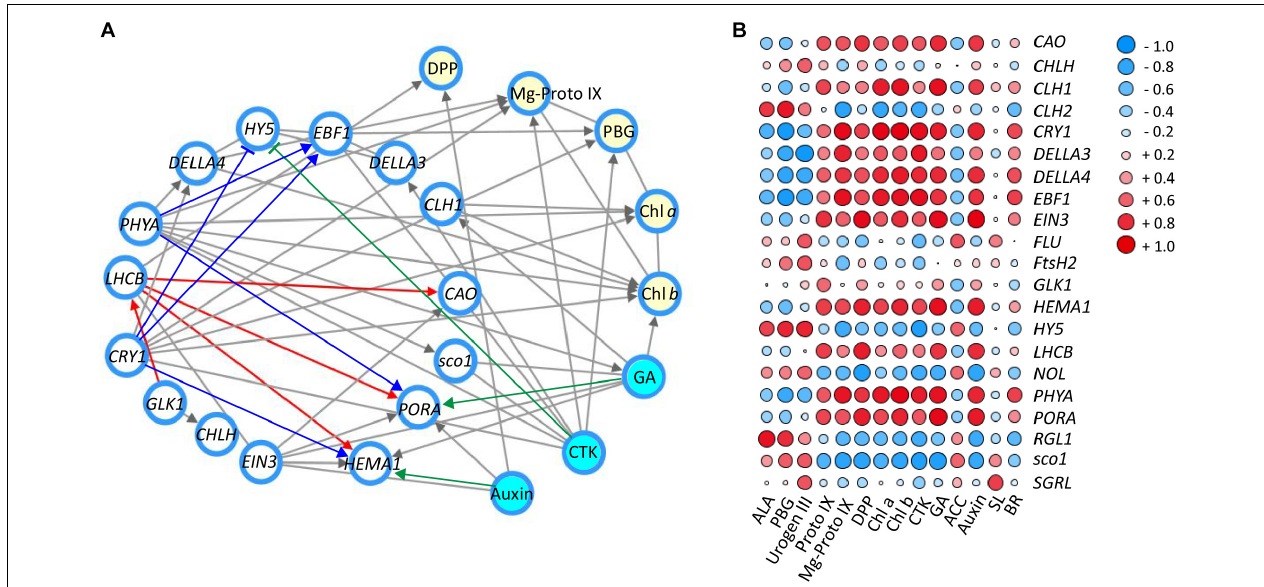
FIGURE 6 | The correlation of genes/TFs, chlorophylls and main precursors and hormones involved in chlorophyll biosynthesis in response to shade treatment. (A) Interaction network of main genes and TFs (white nodes), main compounds (yellow nodes) and hormones (blue nodes) involved in chlorophyll biosynthesis (relevant factor ≥ 0.85). (B) Correlation heatmap between genes and TFs, main compounds and hormones involved in chlorophyll biosynthesis (-1 ∼ 0, expression of genes are negatively correlated; 0, expression of genes are not correlated; 0 ∼ 1, expression of genes are positively correlated). Data shown are conducted of three independent biological replicates ( n = 3), analyzed by the Speaman test in SPSS 13.0 software (IBM SPSS Software, https://www.ibm.com/analytics/datascience/predictive-analytics/spss-statistical-software). The network was conducted by Cytoscape (version